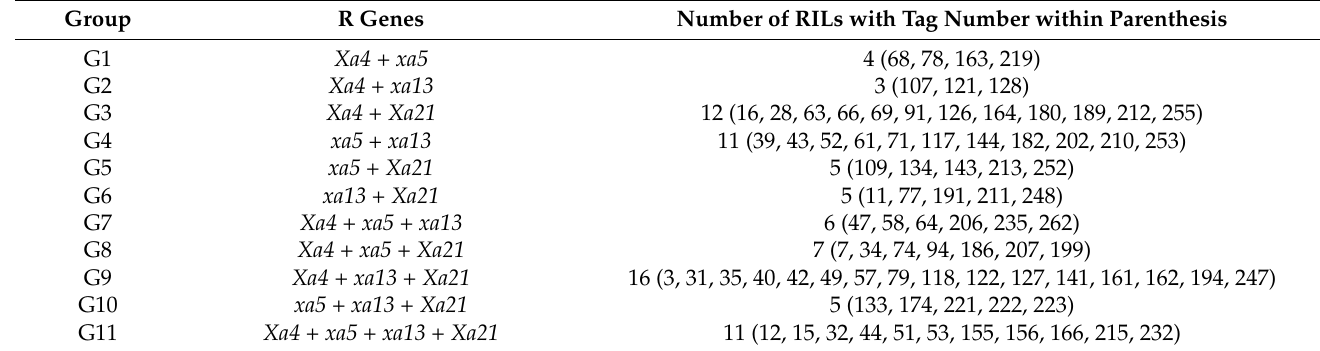
Table 3. Grouping of the pyramided RILs with more than one resistance gene.